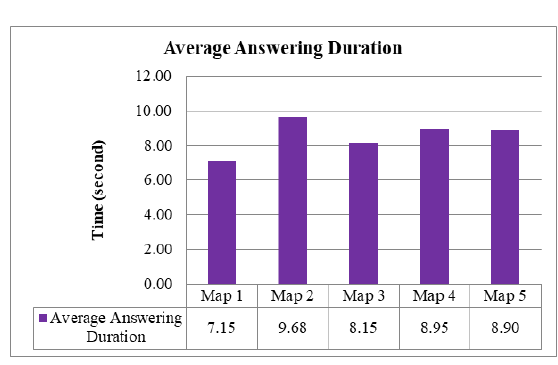
Figure 3 Average Answering Duration